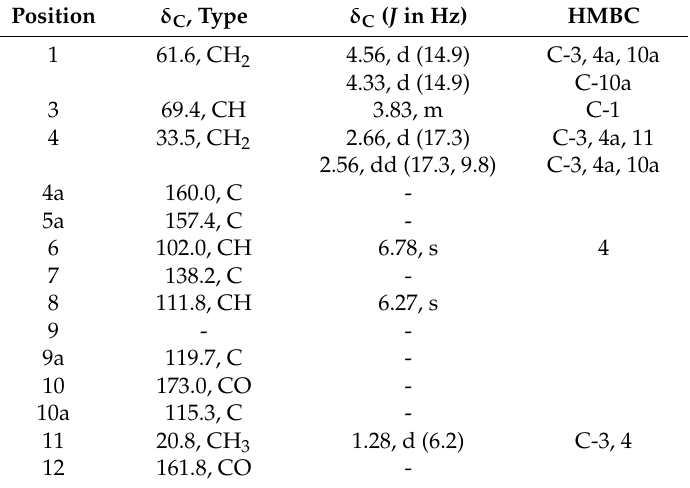
Table 1. The 1 H- and 13 C-NMR (DMSO- d 6 , 500 and 125 MHz) and HMBC assignment for 1 . Position δ C ,